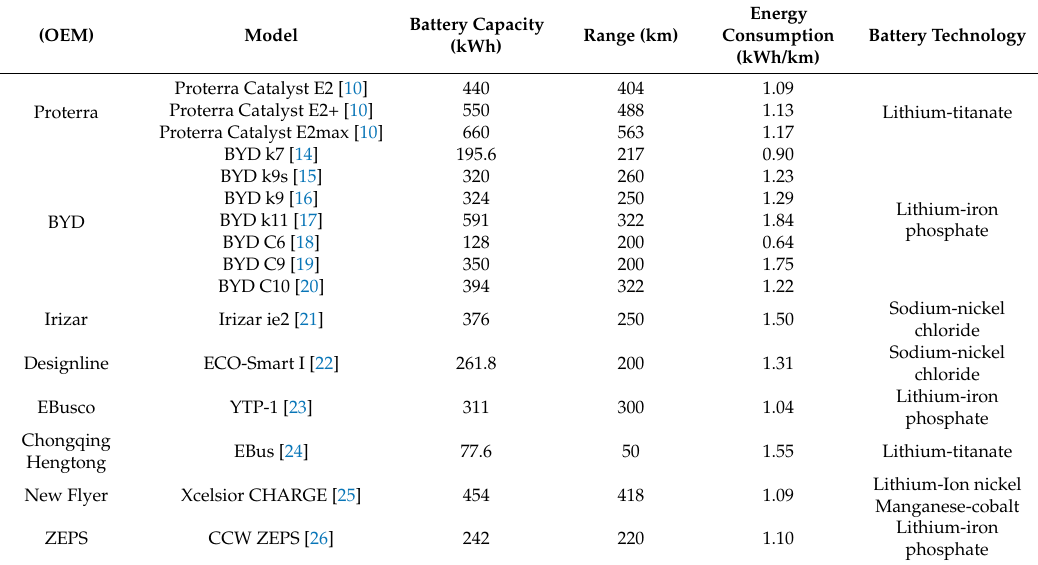
Table 2. Commercially available electric buses and their electrical power